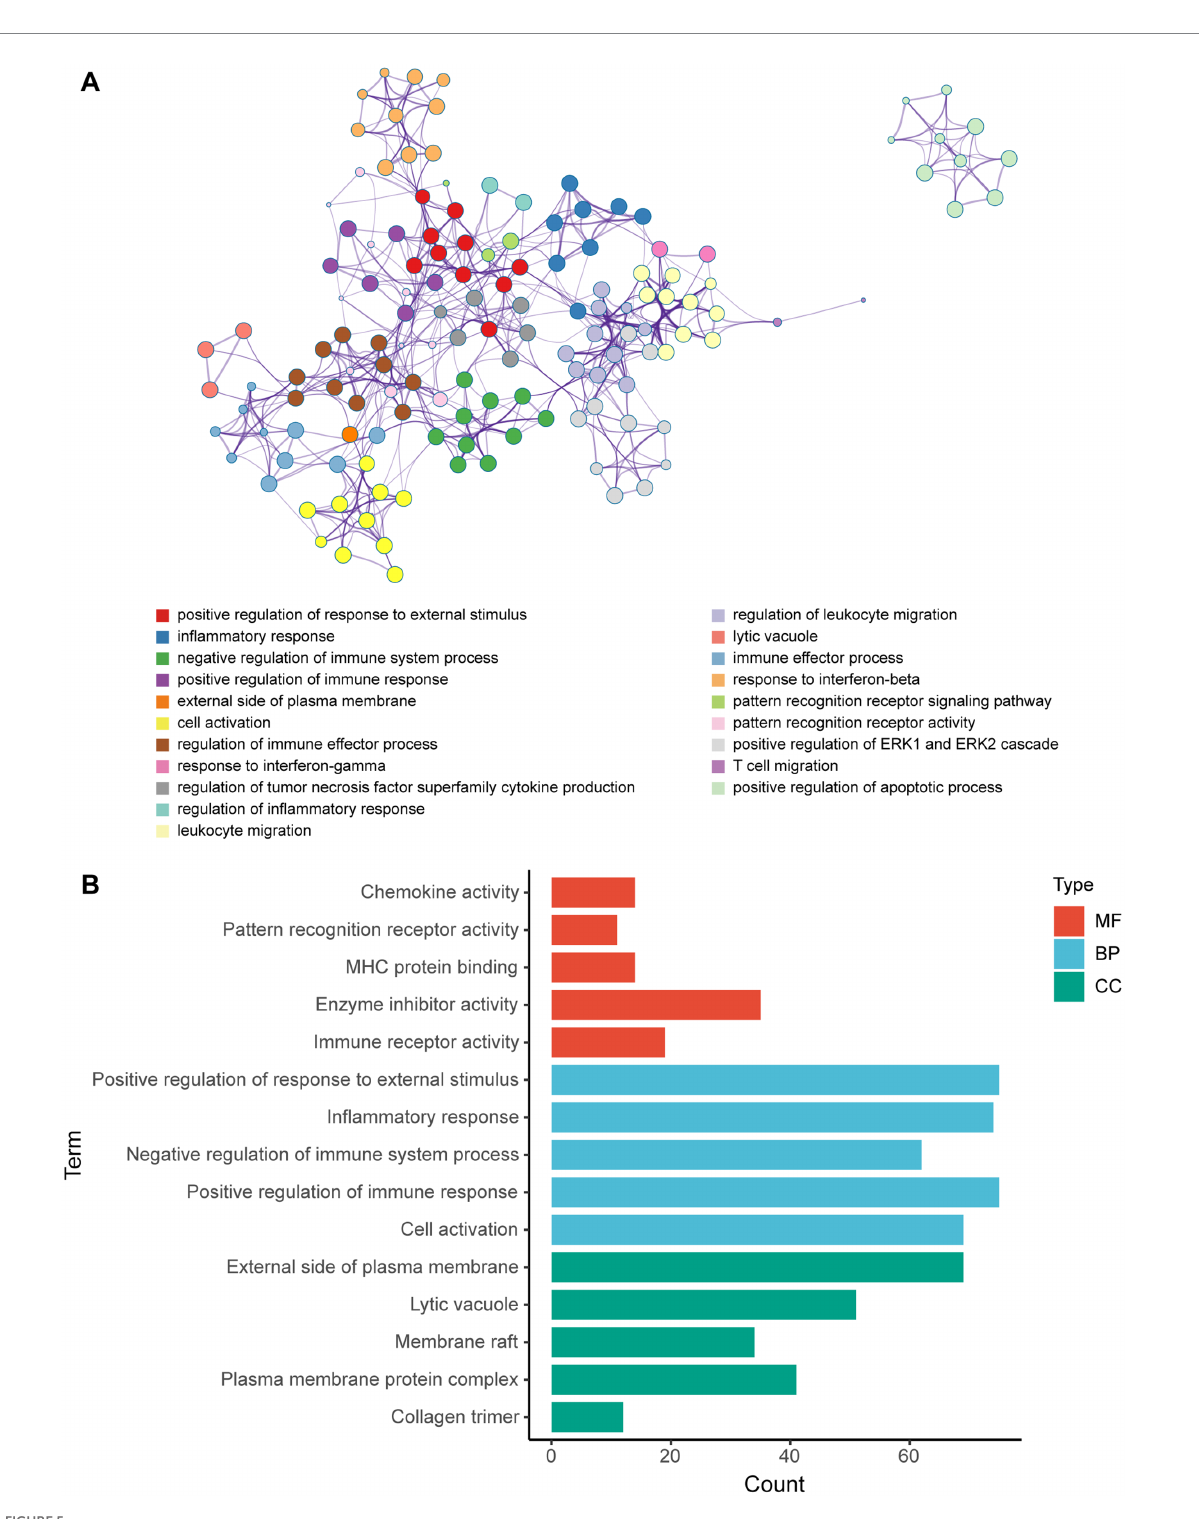
FIGURE 5 GO enrichment analysis of differentially expressed mRNA post-ICH. (A) Network of enriched GO terms. The nodes were colored by cluster-ID. If similarity >0.3, the nodes were connected by edges. (B) The bar graph of the top 5 GO terms in BP, CC, and MF,